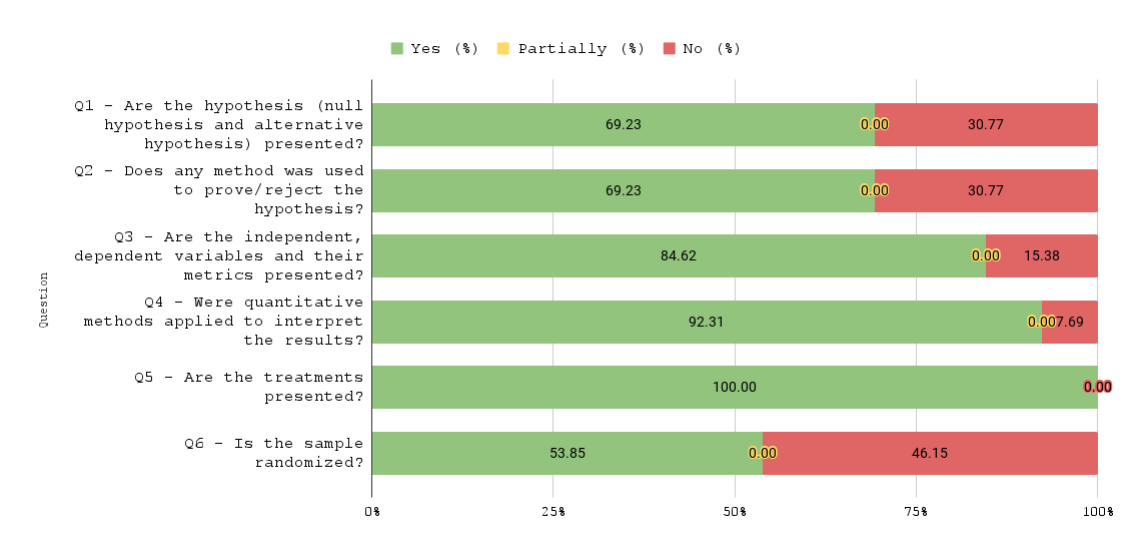
Figure 4. Answers to specific experiments